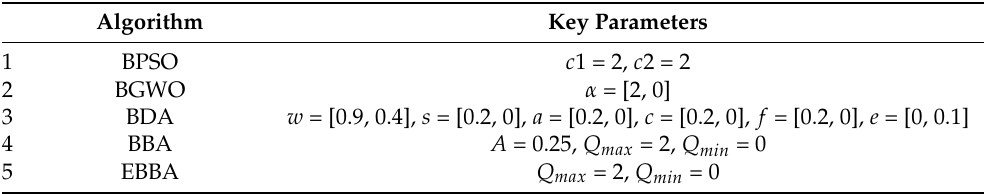
Table 2. Key parameters of benchmark